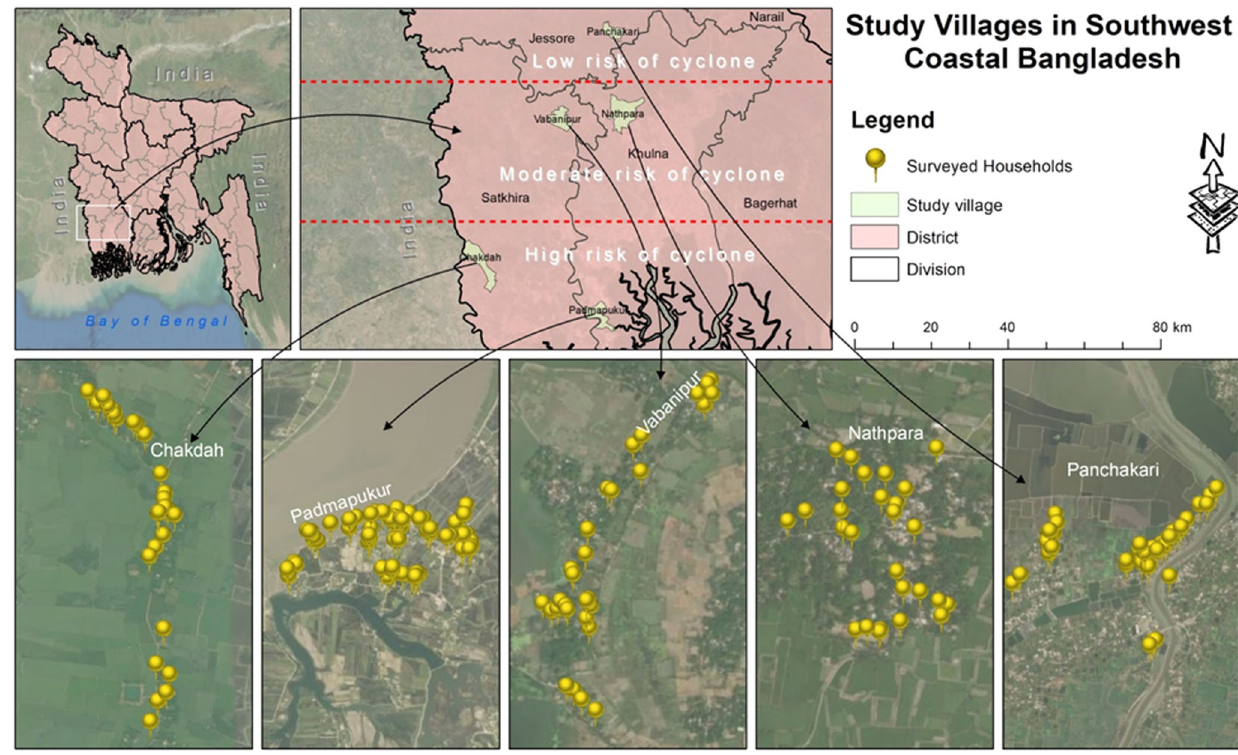
Fig. 2 Study area, southwest coastal Bangladesh. Source: Authors ’ presentation using the data collected from GoB.